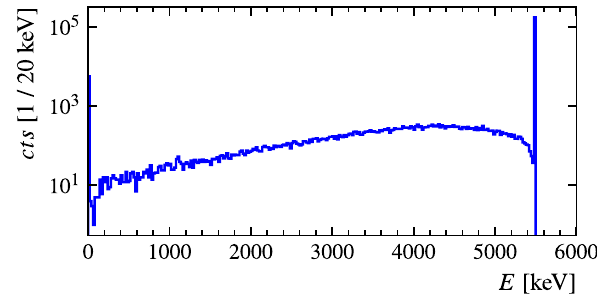
Fig. 5 Energyspectrumofthealphasreachingthedetectoraspredicted by Geant4 for monoenergetic 5.485MeV alphas from the source vol- ume directed downwards with an opening angle of 3 degrees